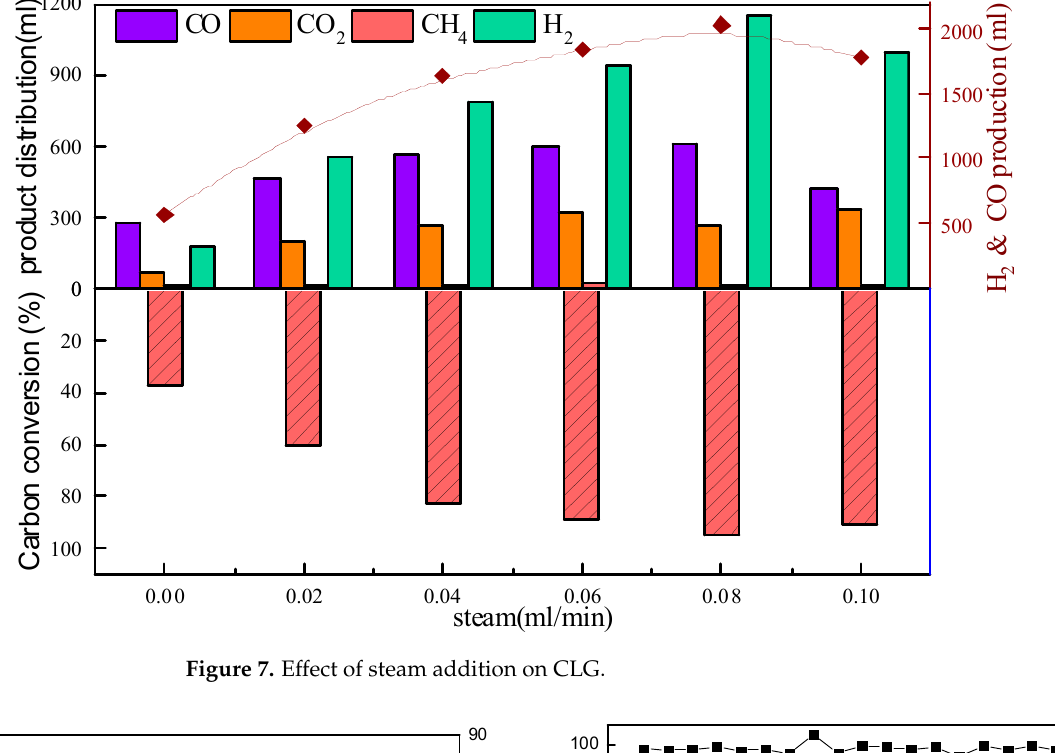
maintained above 80%. In the first five redox experiments, the carbon conversion remained at a high level, while the carbon conversion showed a slight decrease from 5 to 10 cycles and a slightly increasing decrease trend from 10 to 15 cycles. However, the carbon conversion stabilized and showed a small increasing trend after 15 cycles.